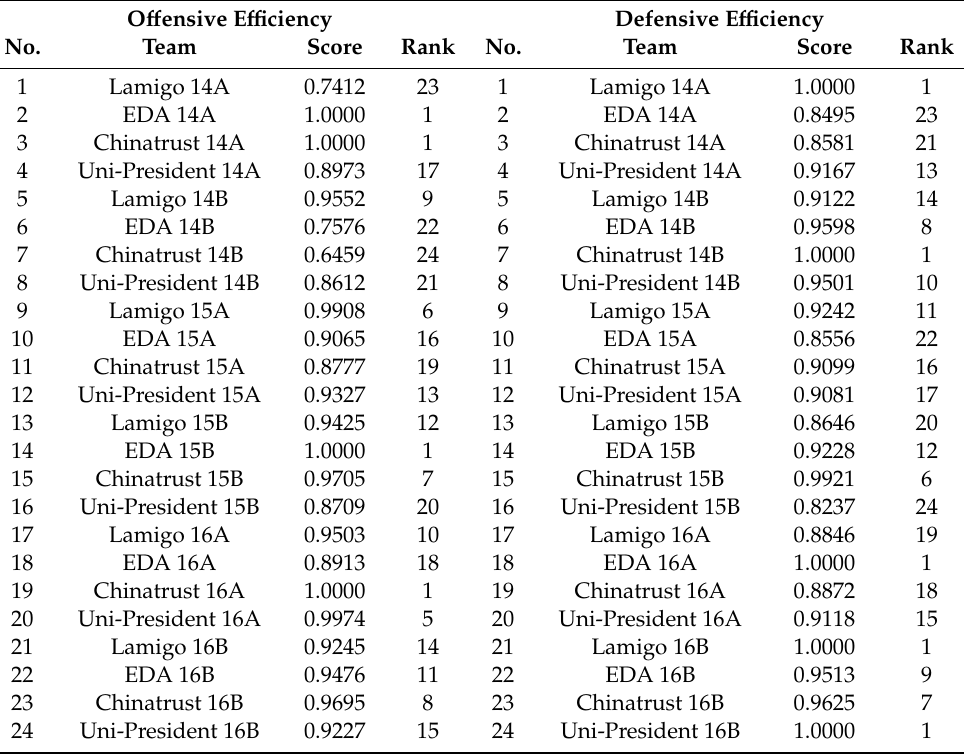
Table 3. O ff ensive and defensive e ffi ciencies and rankings of CPBL teams.